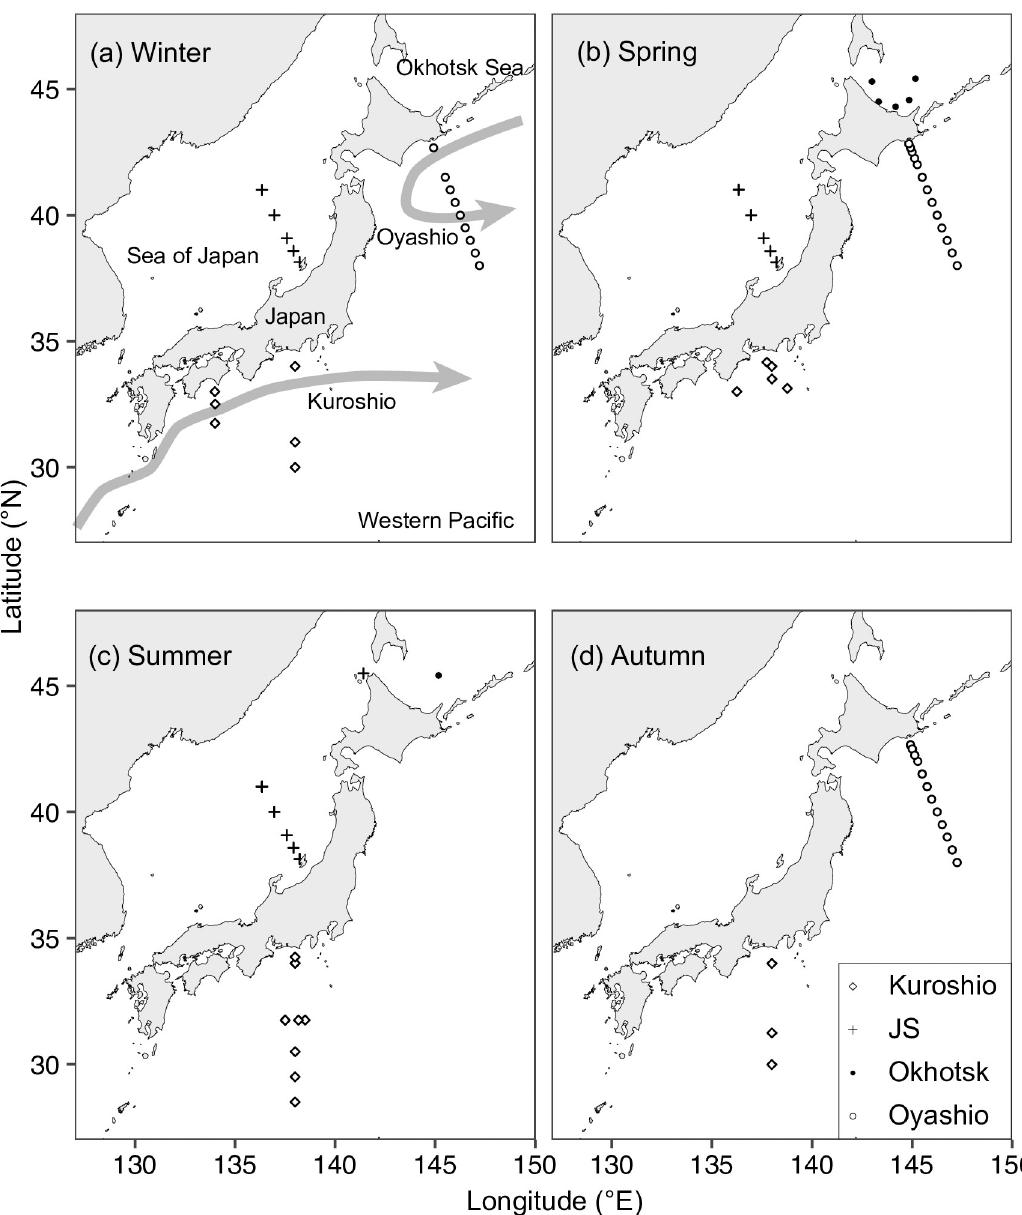
Fig 1. Maps of plant pigment sampling with MEX (Multi-Exciter) observations. Maps show observations in (a) winter, (b) spring, (c) summer, and (d) autumn. Different symbols denote different areas: diamond, Kuroshio; cross, Sea of Japan (JS); closed circle, Okhotsk Sea; and open circle, Oyashio, including the Oyashio–Kuroshio transition. Schematic flows of the Kuroshio and the Oyashio are denoted as arrows. The red points indicated the monitoring stations (A01, C3400, N4, and SI09) of the MEX observations. The map was made with Natural